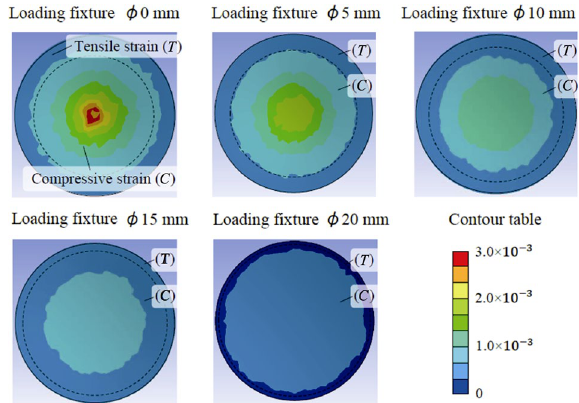
Fig. 9 Distribution of FE strain over PZT ceramic, showing tensile and compressive strains.